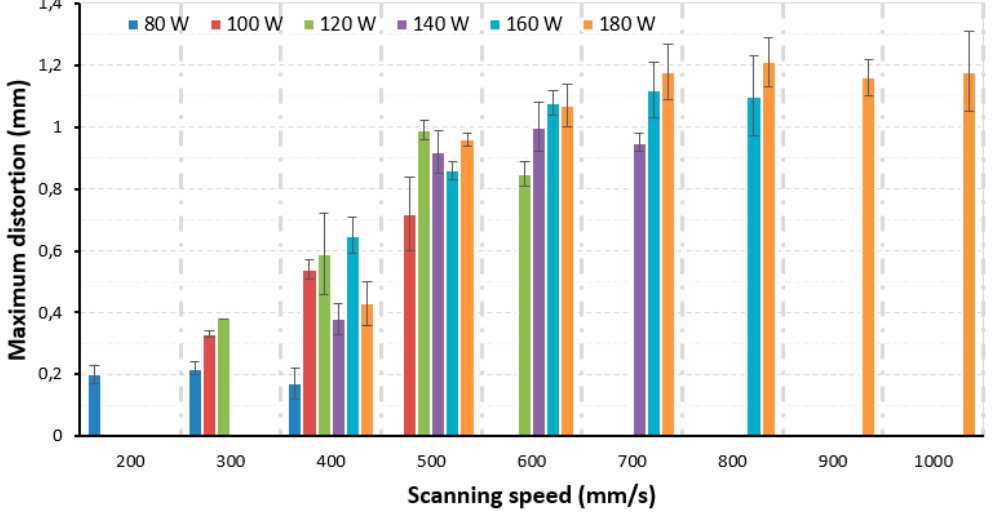
Figure 10. Effect of scanning speed and laser power on distortions at 30-µm layer thickness. Figure 10. E ff ect of scanning speed and laser power on distortions at 30- µ m layer